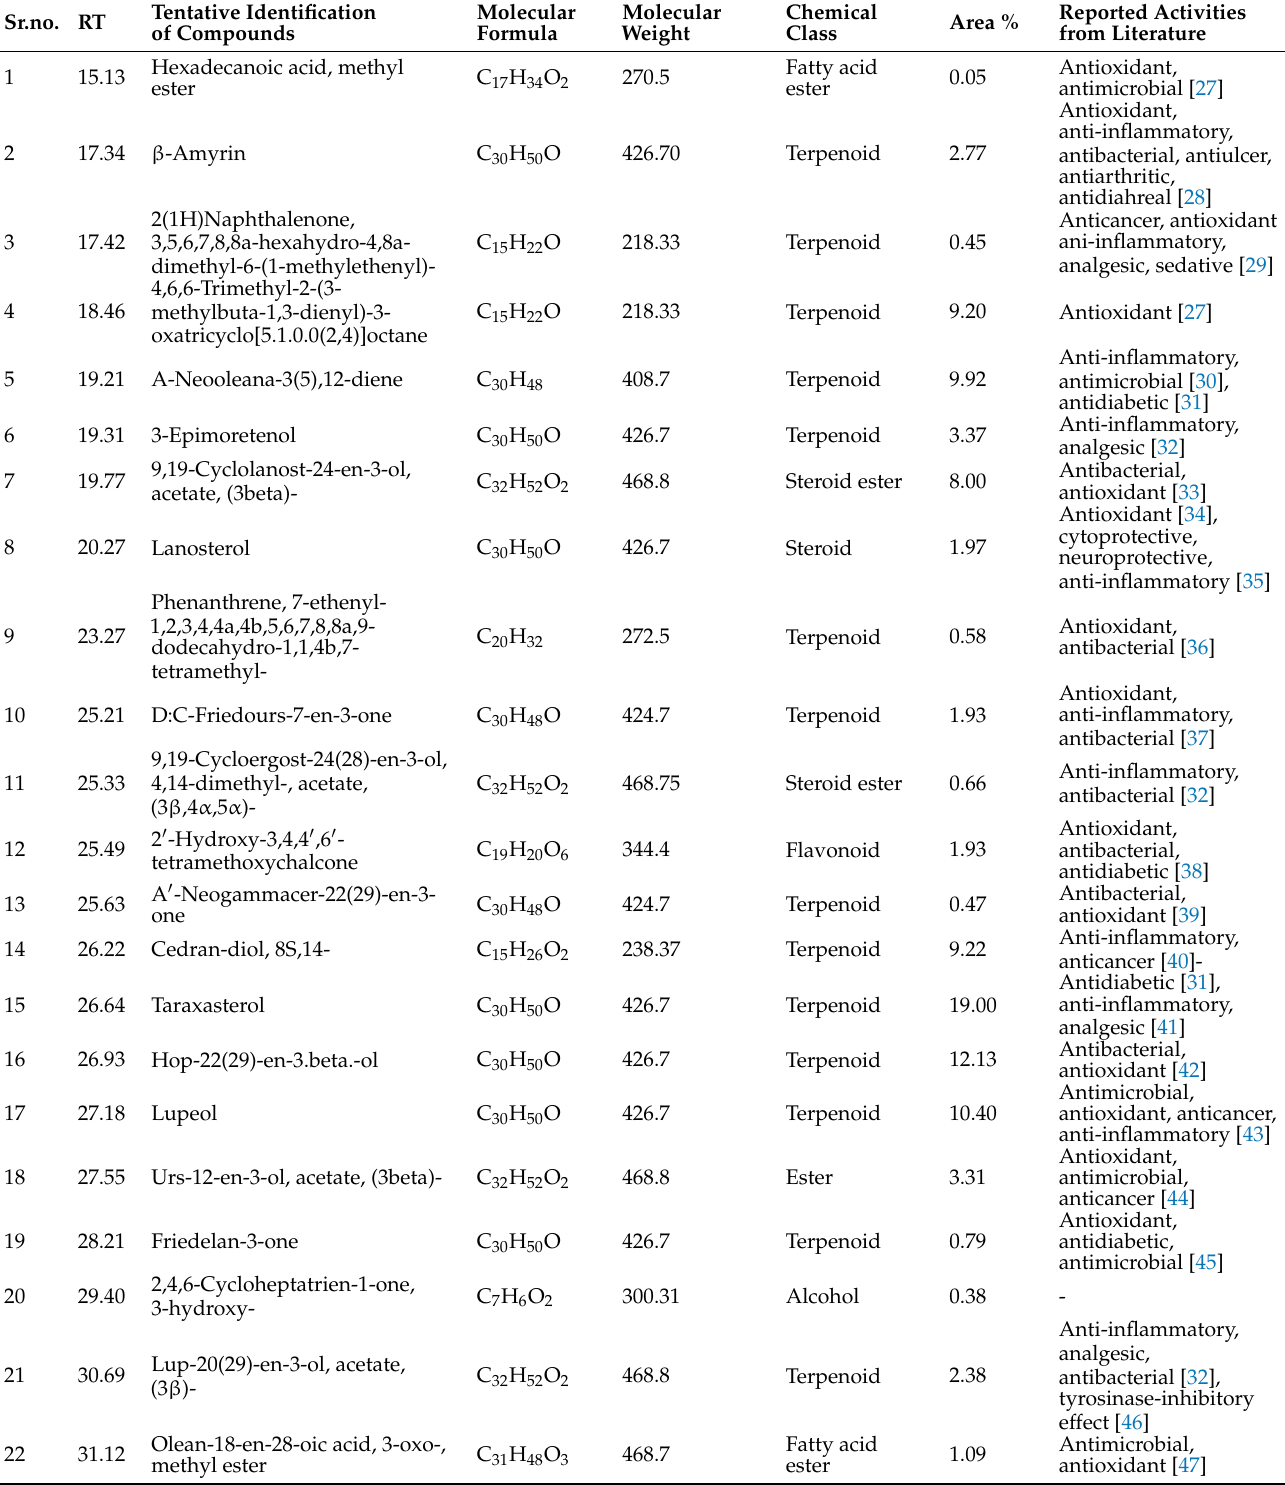
Table 2. Phytochemical profiling of methanolic extract (PCME) of P. candollei through GCMS analysis. Sr.no.